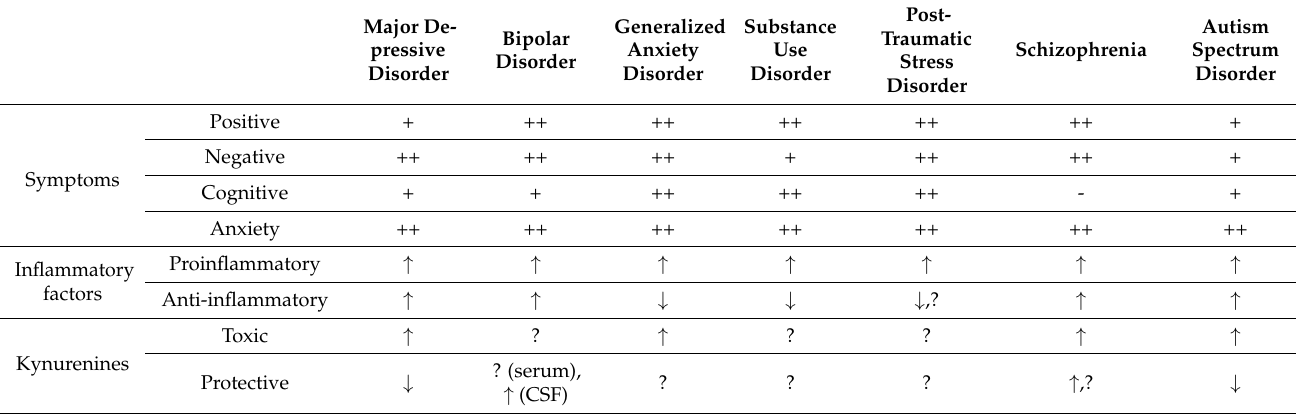
Table 2. The enzymes of the tryptophan-kynurenine pathways and related disease. Major De- pressive